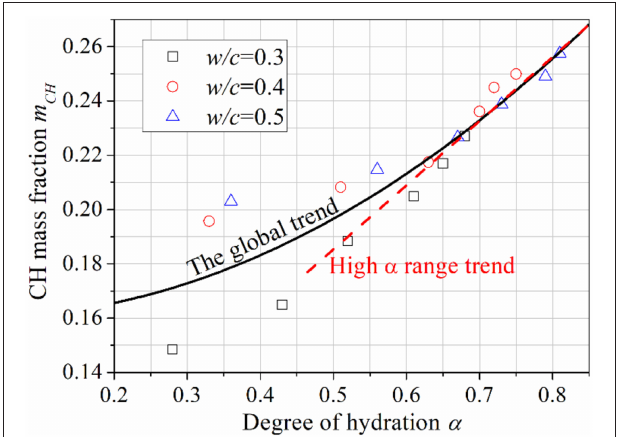
TABLE 3 | Experimental results of plain cement pastes.